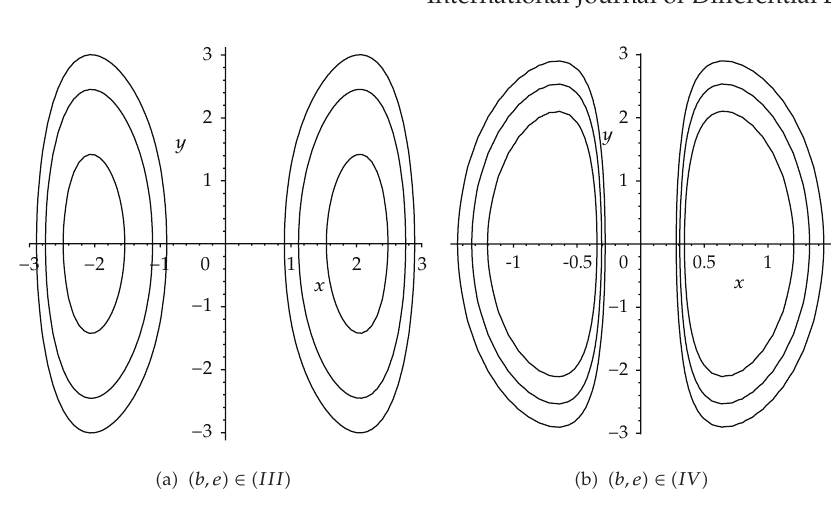
Figure 3: The phase portraits of (cid:8) 2.1 (cid:9) for a <